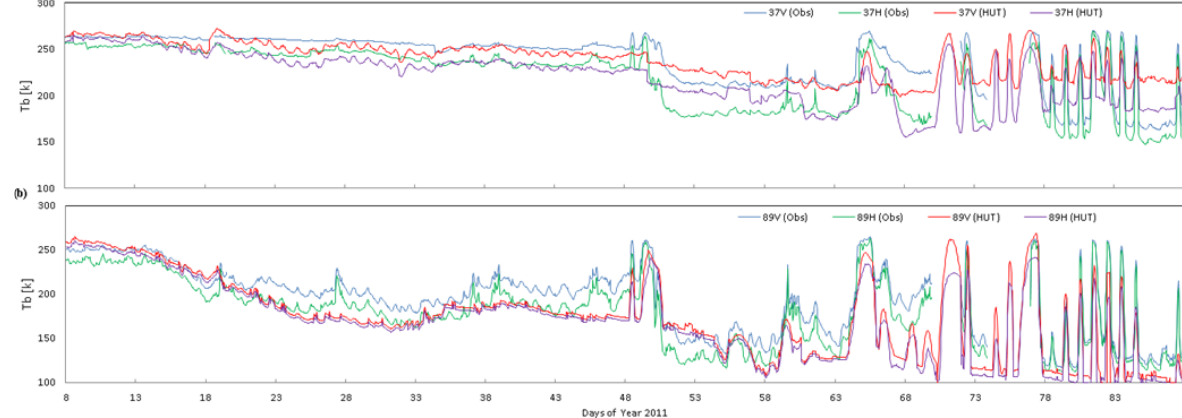
Fig. 9. Comparison of hourly simulated (HUT) and observed brightness temperature for (a) 37 and (b) 89GHz for entire snow